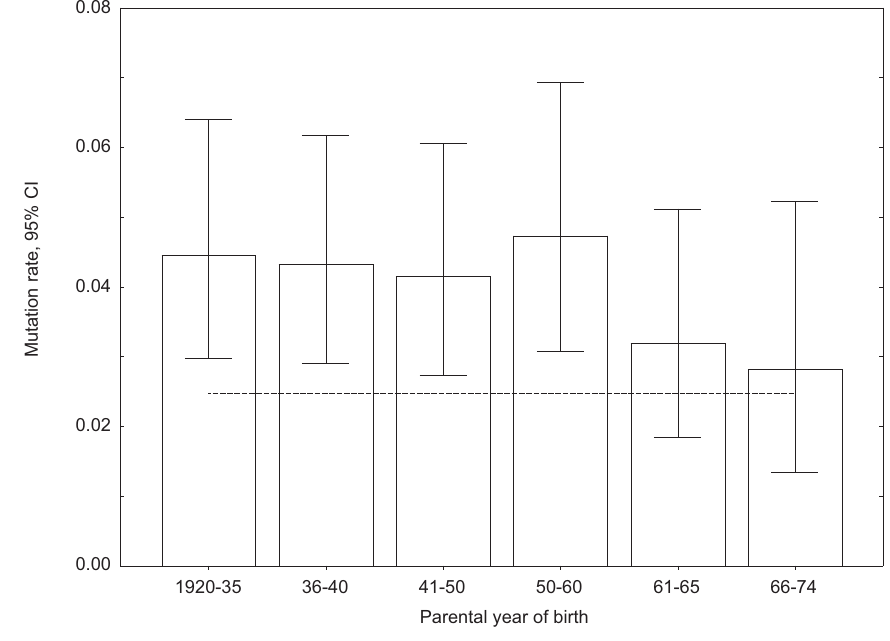
Figure 2 Germline minisatel- lite mutation rate in the exposed parents from the Semi- palatinsk district grouped according to year of birth. The dashed line repre- sents mutation rate in the control group. Data from